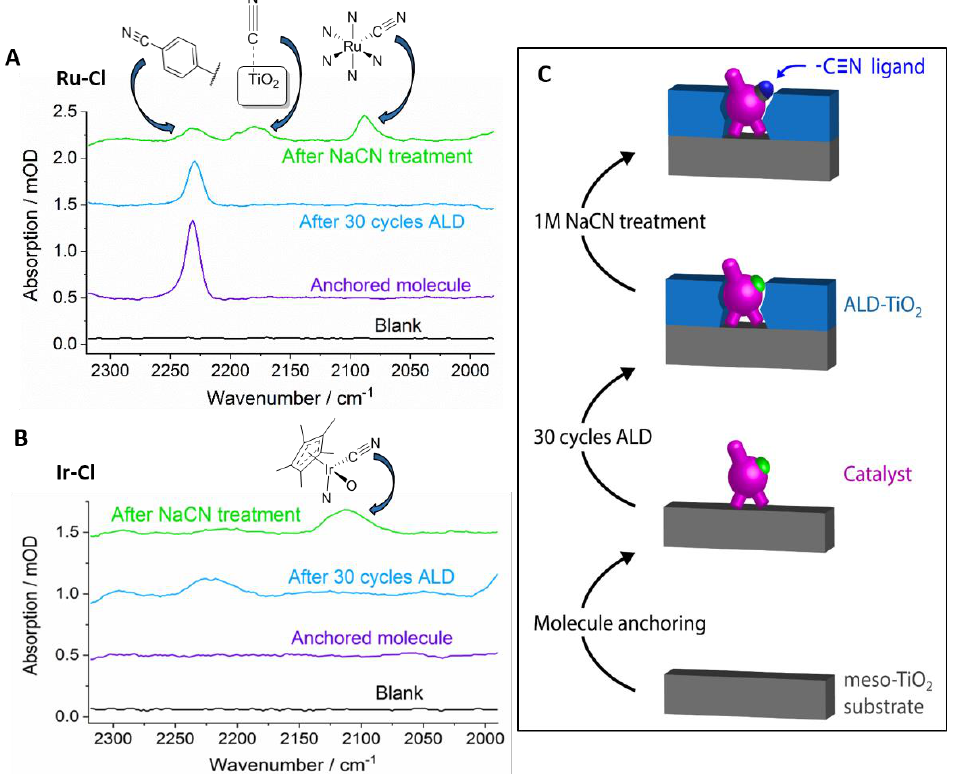
Figure 2. IR spectra of ( A ) Ru – Cl and ( B ) Ir – Cl adsorbed onto meso-TiO 2 after anchoring (purple), after ALD-TiO 2 deposition (blue) and after ligand exchange (green). ( C ) Schematic depiction of the process flow.